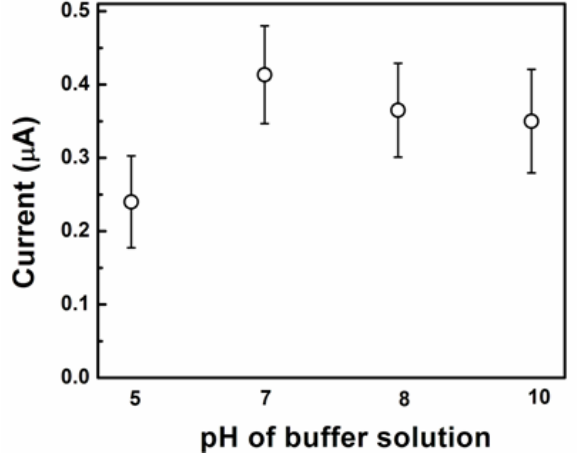
O to various pH values of PBS 2 ] 3−/4− at 50 mV to 5 mM glucose. 6